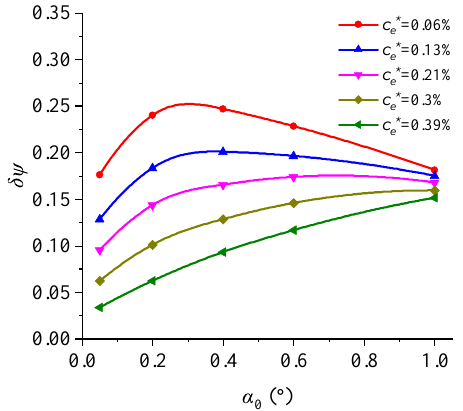
Figure 11. The pressure difference coefficient between the inlet and outlet vs. the guide vane